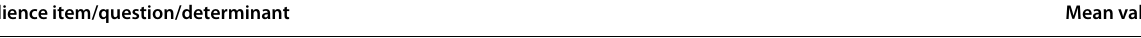
Table 3 The five most important resilience items/questions/determinants in the whole Delphi panel (the bold text is used to highlight the item/issue/topic in